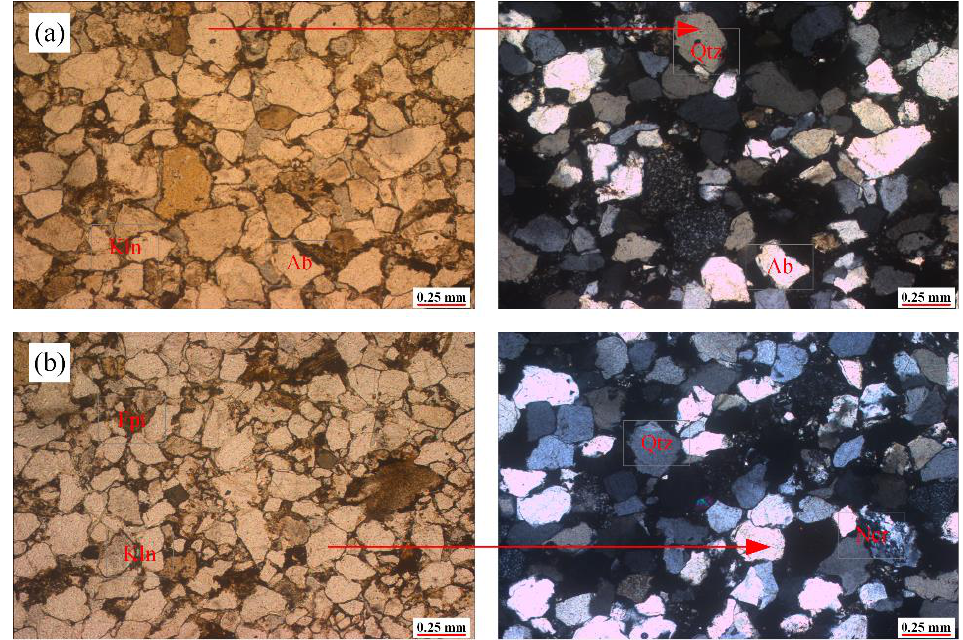
Figure 3. Thin section photomicrographs. ( a ) 0 F-T cycle; ( b ) 15 F-T cycles. Before the F-T testing, all the samples were left to dry in an oven (110 ◦ C) until the mass remained constant and then cooled to room temperature in a dry environment (Figure 4), while the dry mass, P-wave velocity, and volume of the sample were measured. Then, all the samples were kept in distilled water and saturated by the vacuum equipment with the fixed vacuum pressure of 100 kPa and the saturation time of 12 h [21]. Next, the samples were submerged completely in distilled water under vacuum conditions (total 24 h). Finally, the initial physical properties were obtained. The average values are listed in Table 1.